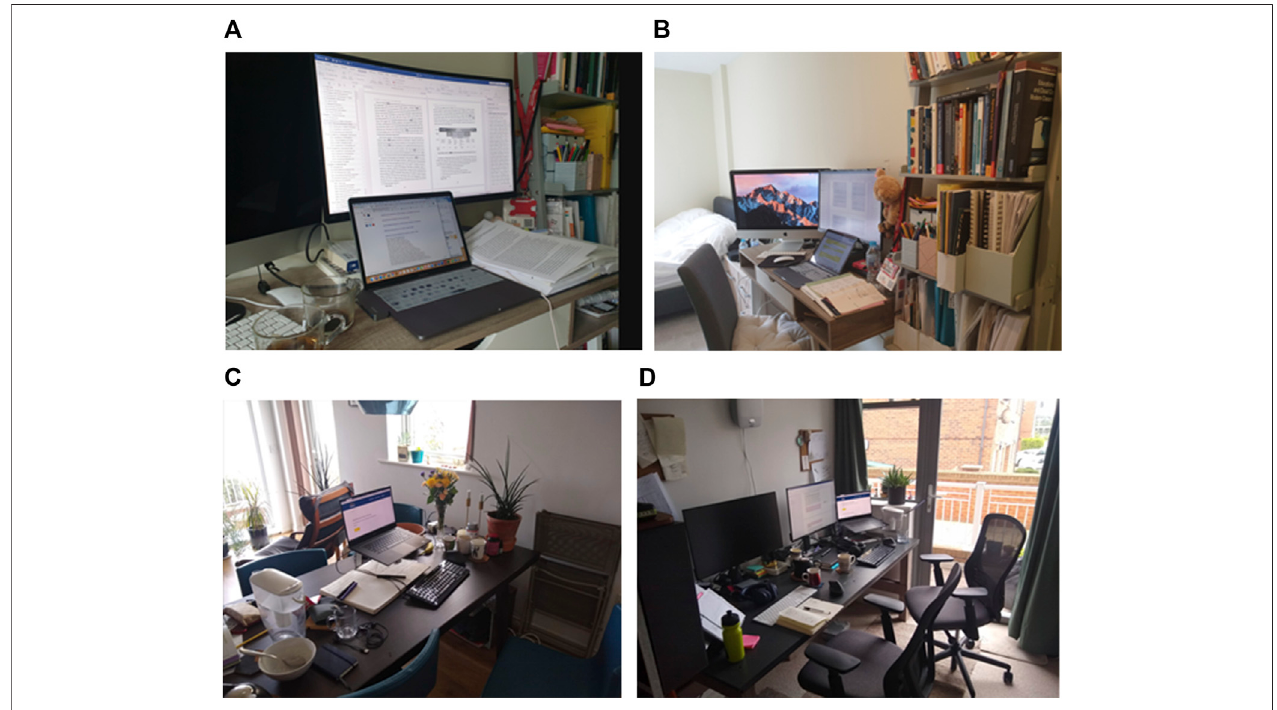
FIGURE 3 | Basic ergonomics in limited space: leveling and displays.